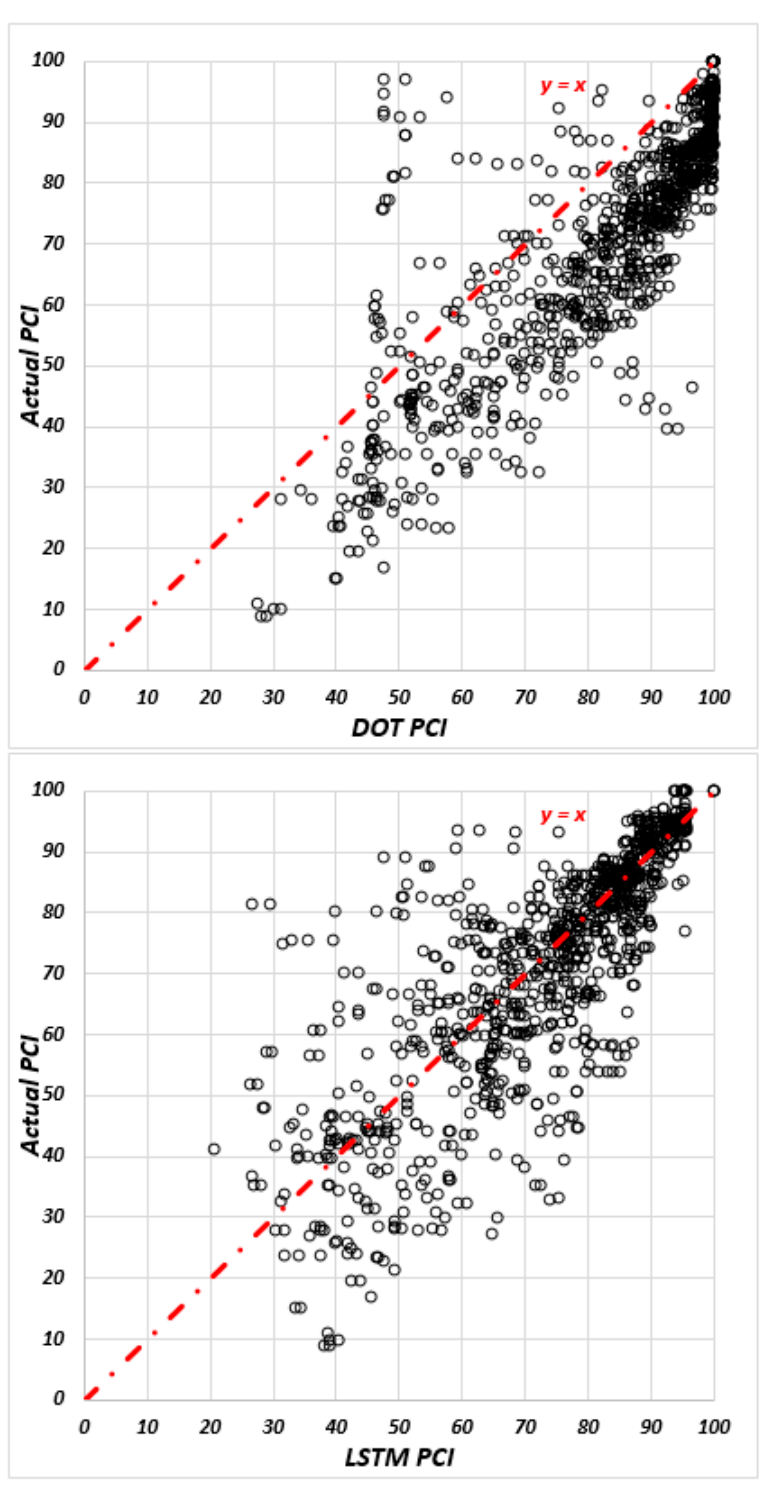
Figure 4. The actual PCI over predicted PCI in AC sections for DOT and LSTM models, respectively.